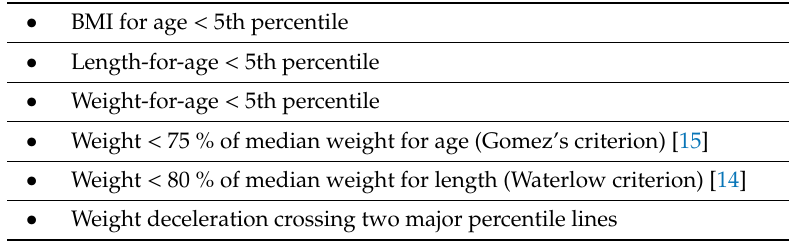
Table 1. Faltering growth: most commonly used anthropometric